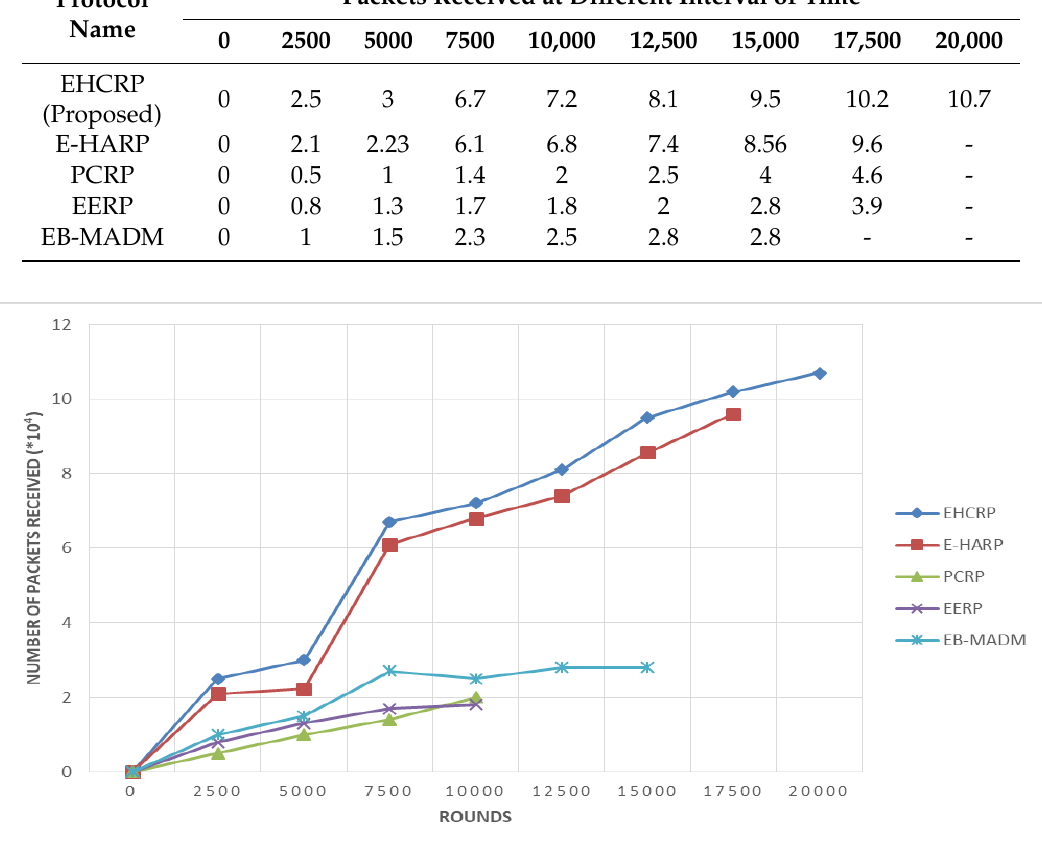
Table 8. End-to-End delay vs. time(s).